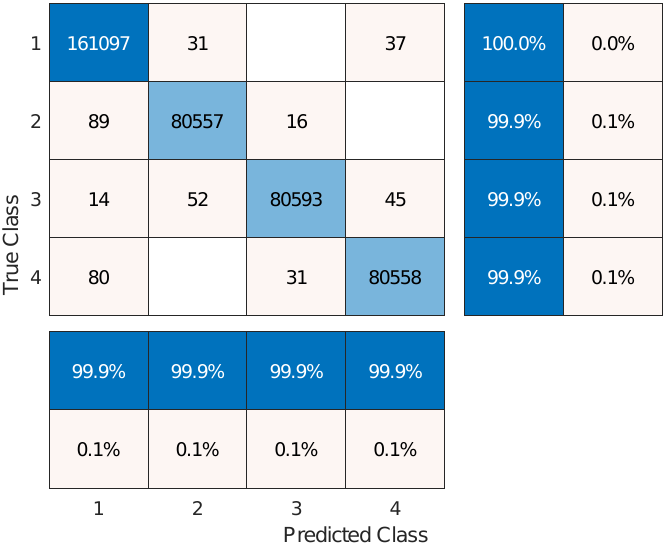
Figure 9. Confusion matrix for the validation dataset with data augmentation.